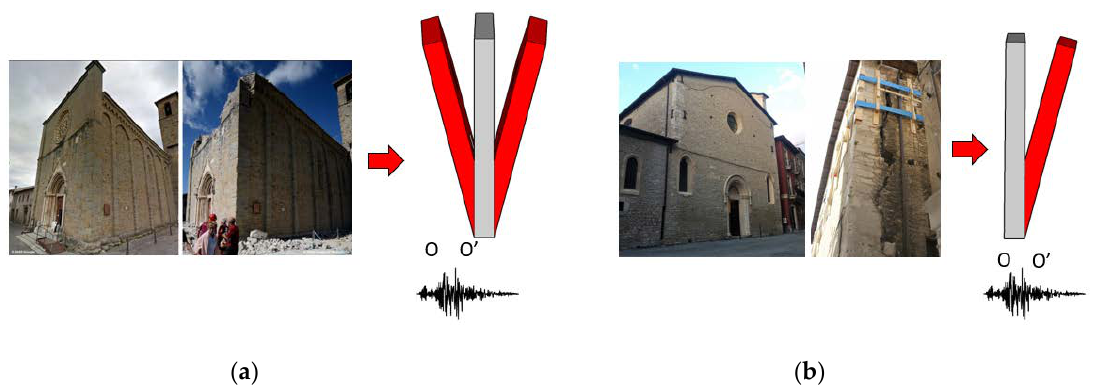
Figure 4. Collapse mechanisms occurring in the out-of-plane behaviour: ( a ) two-side rocking motion (images from https://www.dw.com/de/ein-beben-ersch%C3%BCttert-italiens-kultur/a-19515621-0); ( b ) one-side rocking motion (images from http://www.lct-architettura.it/Restauri/&id=91).